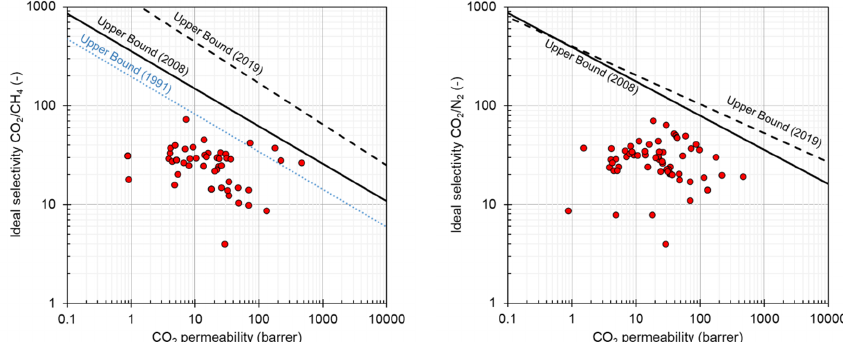
Figure 7. Robeson plots for CO 2 /CH 4 (left) and CO 2 /N 2 (right) for PILs (Table 5) with corresponding upper bounds from 1991 [238], 2008 [239], and 2019 [240]. (1 Barrer = 10 − 10 cm 3STP cm cm − 2 s -1 cmHg − 1 = 3.348 × 10 − 16 mol m m − 2 s − 1 Pa − 1